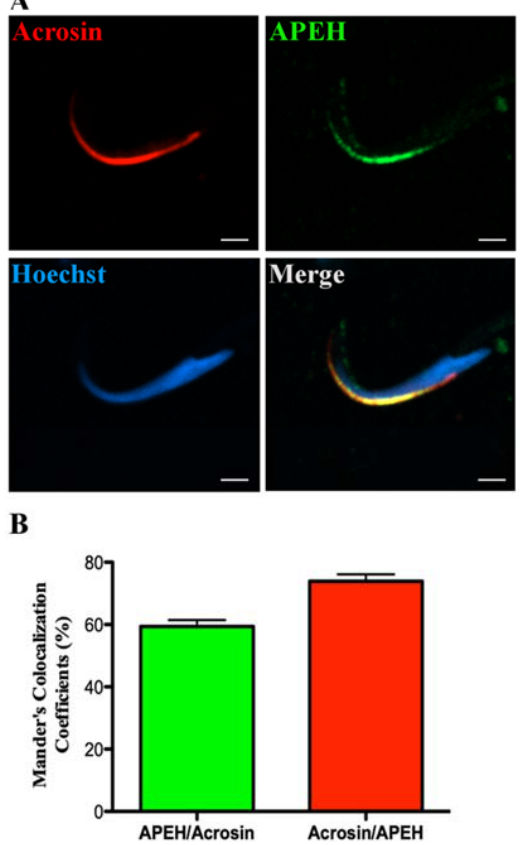
Figure 5. APEH colocalizes with Acrosin in rat sperm heads. ( A ) Immunofluorescence against APEH (green) and Acrosin (red) in spermatozoa obtained from epididymal cauda of male rats. ( B ) Quantification of APEH colocalization with Acrosin. Twenty-one sperm were checked for the determination of Mander’s colocalization coefficient. Nuclei were stained with Hoechst 33342 (blue). Scale bar = 2 µm.